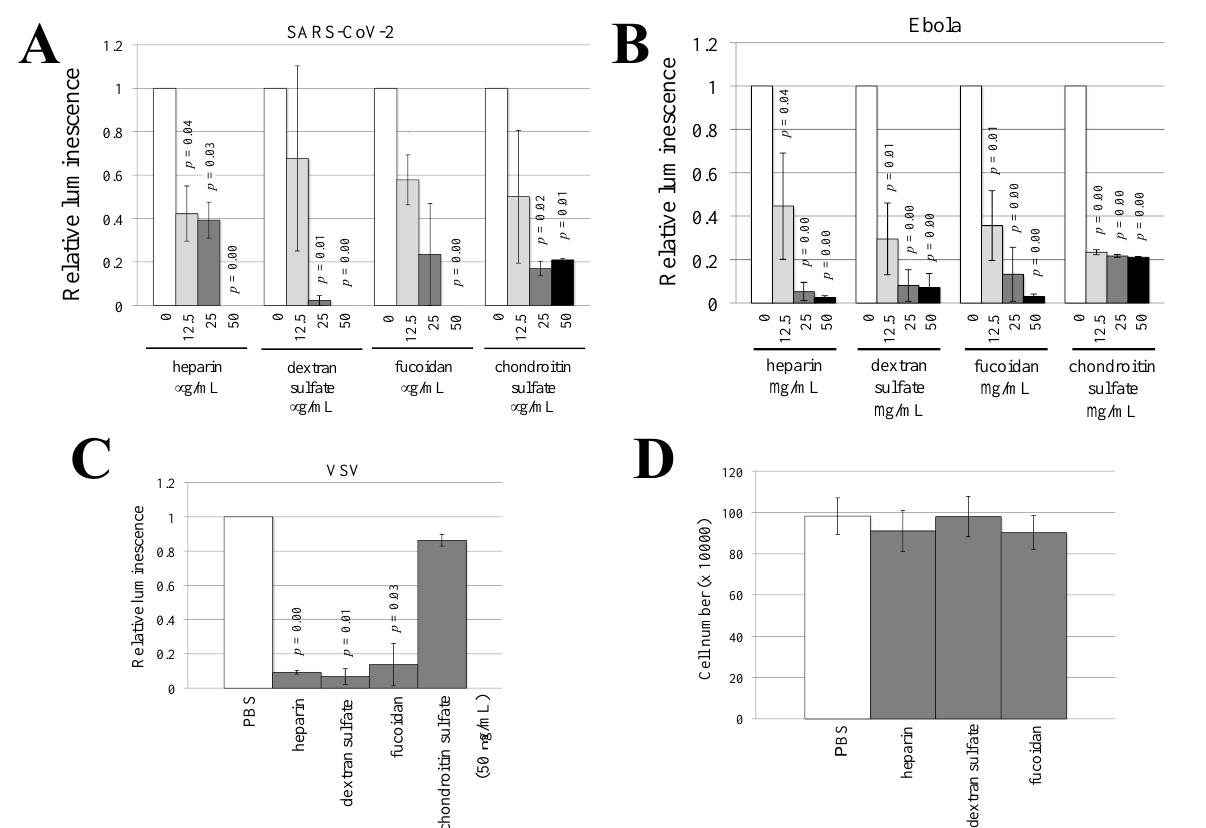
Figure 4. Sulfated polysaccharides inhibit pseudotyped HIV-1 vector infection. ( A ) Human 293T cells were pretreated with the indicated sulfated polysaccharide for 5 h and inoculated with the SARS-CoV-2-pseudotyped HIV-1 vector. The luciferase activities of the PBS-treated cells were always set to 1, and the relative values to the luciferase activities of the PBS-treated cells are indicated. This experiment was repeated three times. ( B , C ) Human 293T cells were pretreated with the indicated polysaccharides and inoculated with Ebola virus-(B) or VSV-(C) pseudotyped HIV-1 vector. ( D ) Human 293T cells were treated with the indicated polysaccharides for 2 days and stained with trypan blue. The unstained live cells were counted. This experiment was repeated three times. Error bars indicate SD. When the differences compared to the control cells are significant, the p values of Student ’s t -test are indicated.